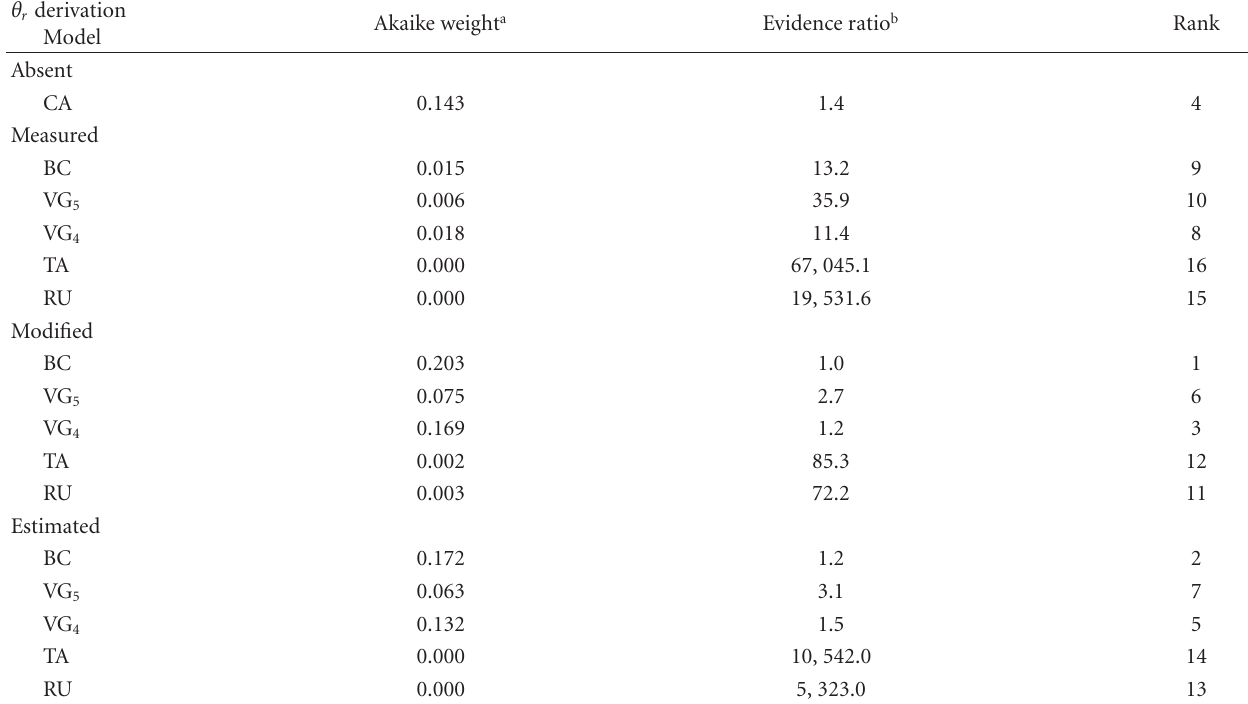
Table 3: Akaike weights and evidence ratios for the soil water retention